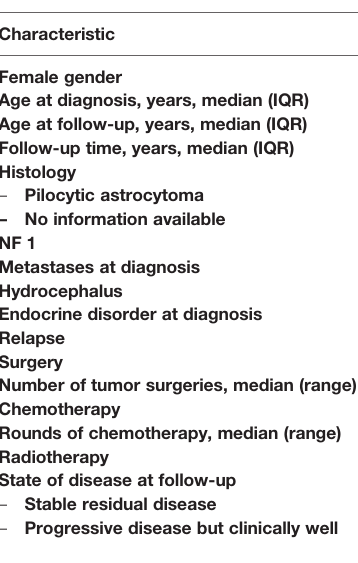
TABLE 1 | Descriptive characteristics of the 10 patients.